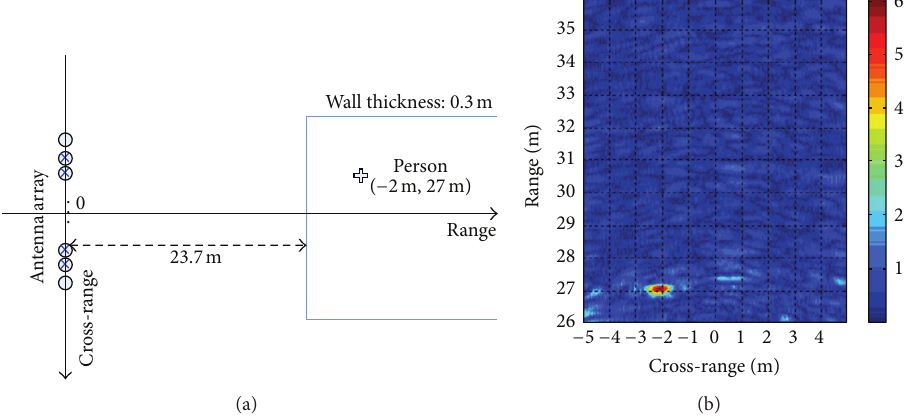
Figure 8: Image of a person inside the building. (a) Geometry of imaging. (b) Imaging